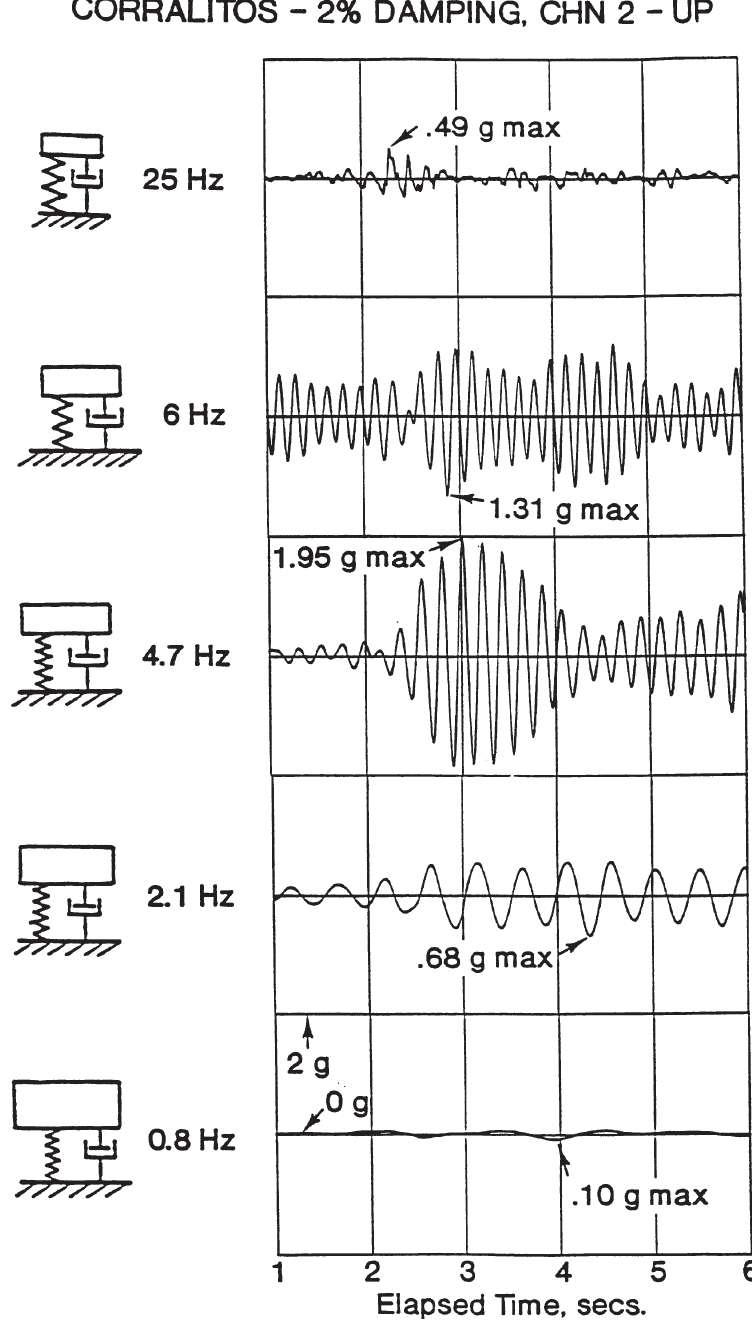
Fig. 3. Acceleration (g-level) time-history-response at Corralitos station during the 1989 Loma Prieta